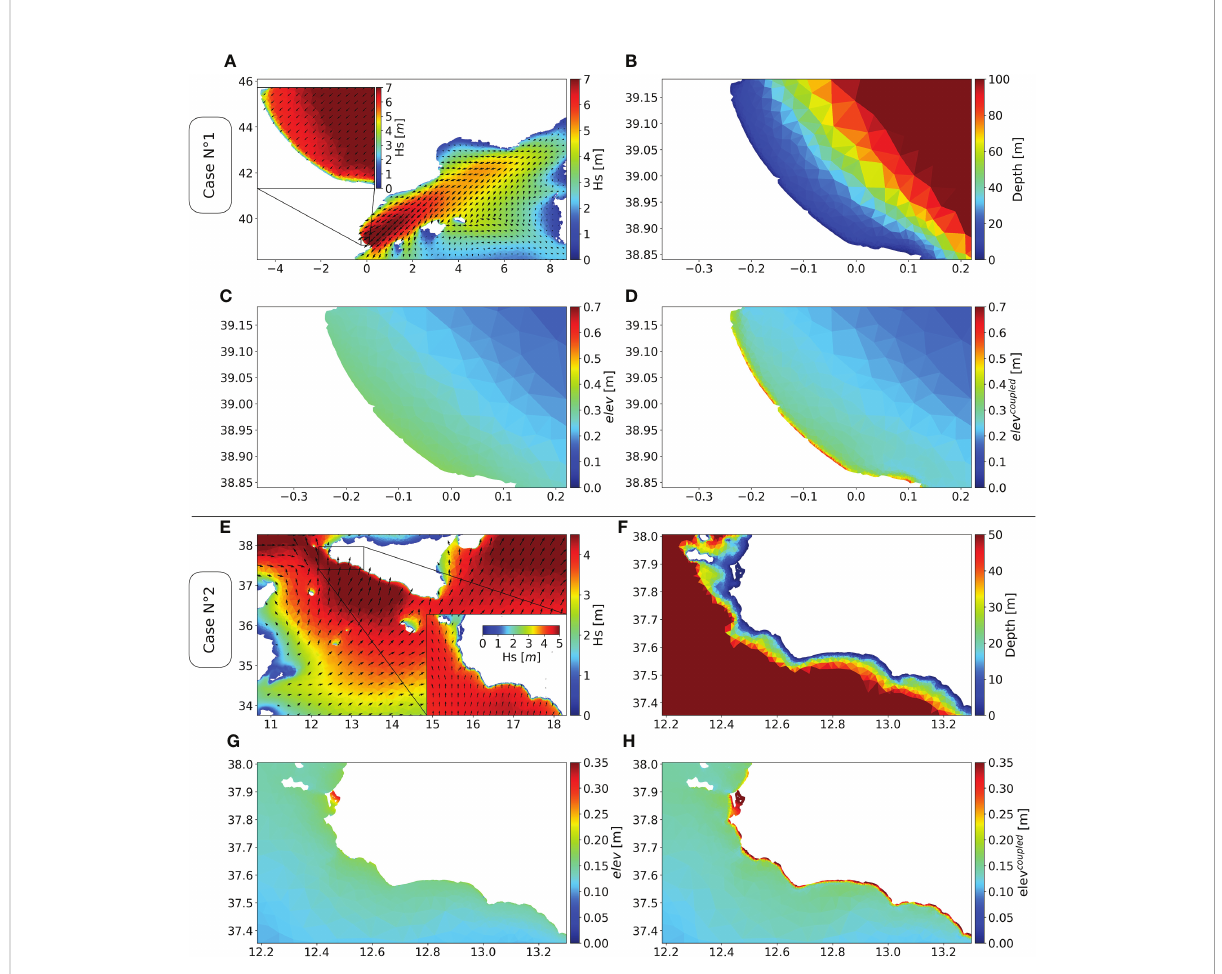
FIGURE 8 Snapshots of simulated sea surface elevation and H S generated by two independent storms. Case N °1 corresponds to the Gloria storm that hit eastern Spanish coasts in January 2020 (snapshot on day 20, at 07:00). Case N °2 corresponds to a wave storm that impacted southern coast of Sicily in December 2004 (snapshot on day 26, at 21:00). For both cases, upper left panel (A, E) shows simulated H S for a large area and a zoom of a smaller zone within it. Upper right (B, F) , lower left (C, G) and lower right (D, H) panels show respectively the bathymetry, the elev and the elev coupled of the zoomed